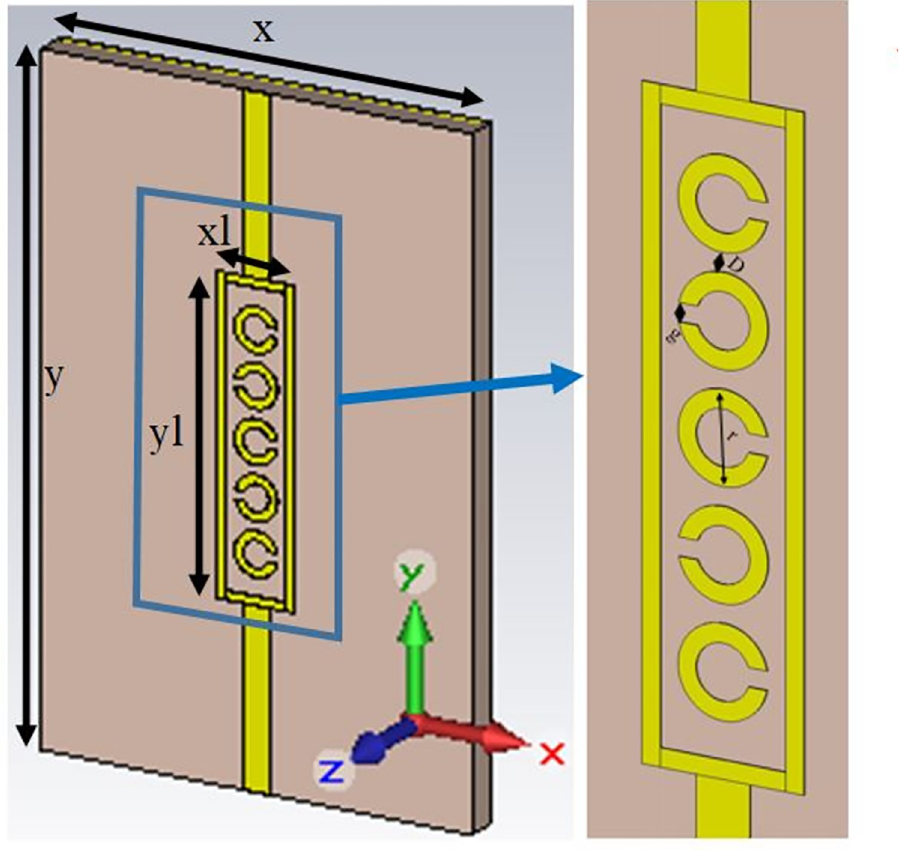
Fig 1. Perspective view of the design.